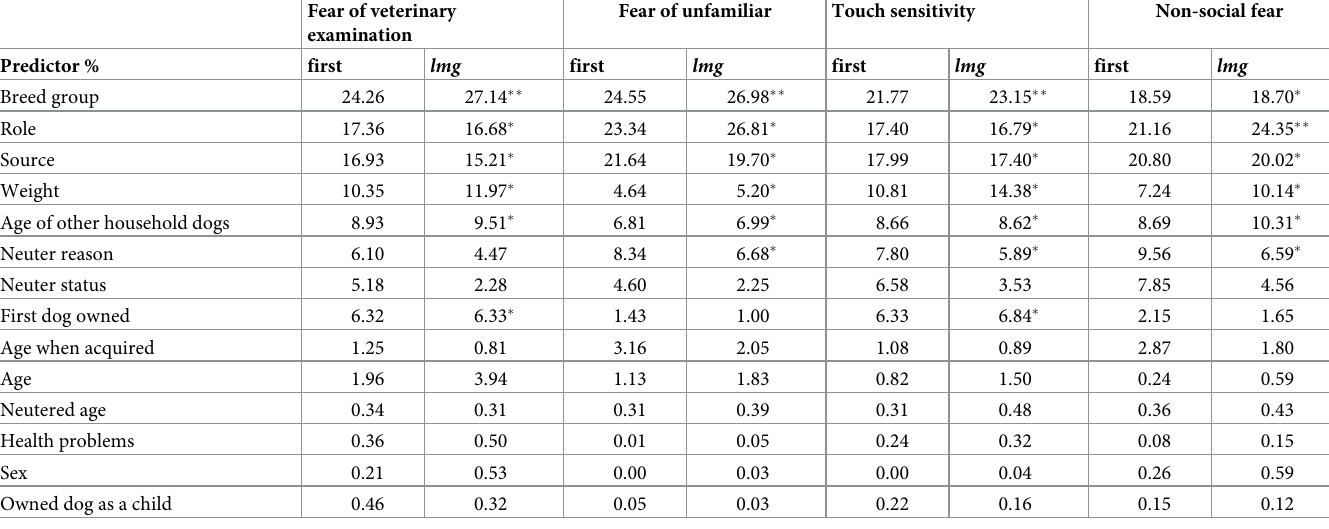
Table 3. Relative variable importance (%) in predicting fearful behaviour from C-BARQ items fear of veterinary examination and fear of unfamiliar and subscales touch sensitivity and non-social fear in a bivariate (‘first’) and multivariate (‘ lmg ’) context. lmg scores that indicate the variable captures more than 5% of explained variance in fearfulness are discussed in